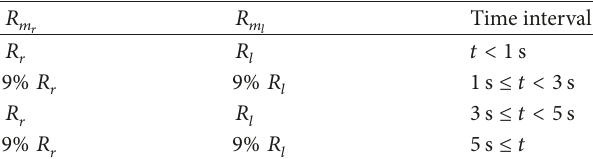
Table 2: Abrupt changes in 𝑅 𝑟 and 𝑅 𝑙 .